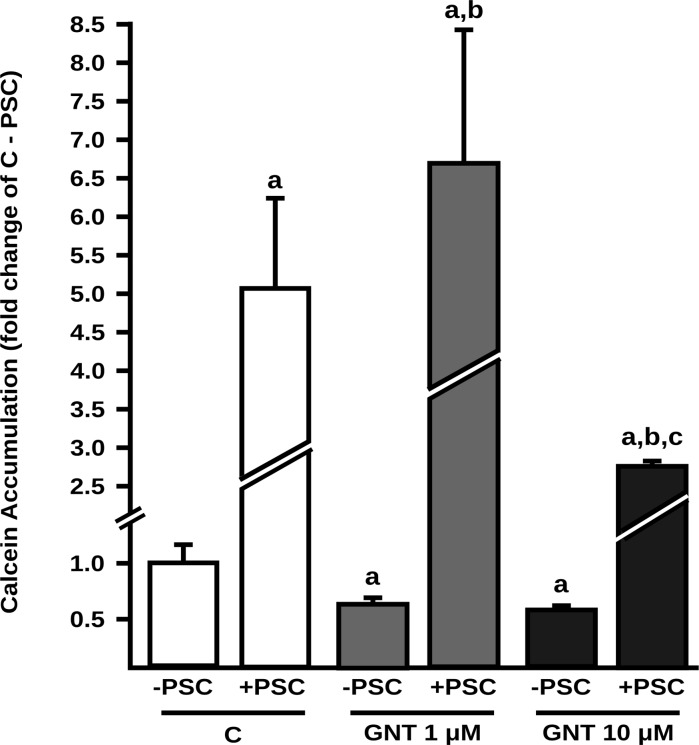
Effect of GNT on P-gp activity.Calcein accumulation is directly associated to accumulation of its non fluorescent precursor calcein-AM (P-gp substrate) and was quantified by flow cytometry in control (C) and GNT treated cells (1.0 and 10 μM, 48 h) in the absence (- PSC) or presence (+ PSC) of the P-gp specific inhibitor PSC833 (10 μM). Data (mean ± S.D., n = 3) are presented as fold change of the calcein accumulation in C—PSC, considered as 1. a: different from C—PSC, b: different from GNT 1.0 μM—PSC; c: different from GNT 10—PSC. p<0.05.